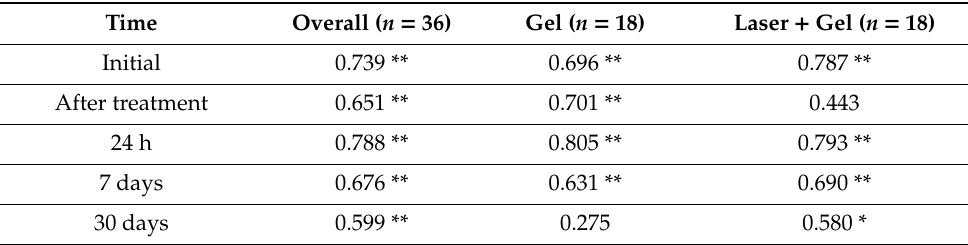
Table 5. Concurrent validity of the dentin sensitivity measurements: Spearman correlation coe ffi cients between VRS scores and Laser Doppler flowmetry